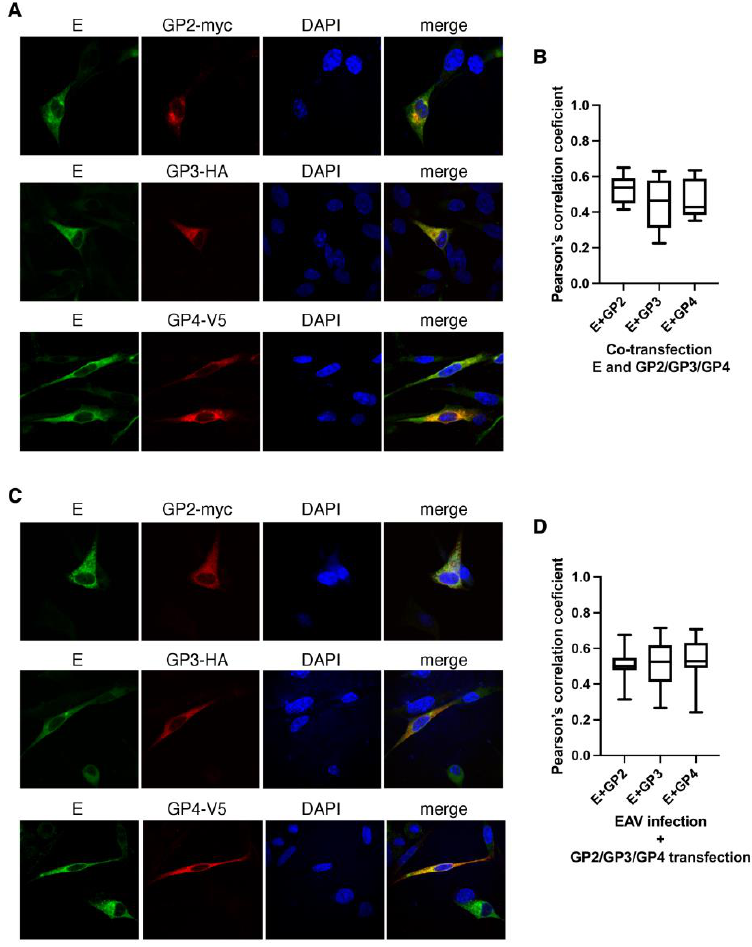
Figure 6. GP2-myc, GP3-HA, and GP4-V5 co-localize with E protein. BHK-21 cells were co-transfected with pGP2/GP3/GP4 and E in pMDK. ( A , B ) Then, 22 h after transfection, cells were fixed and subjected to immunofluorescence with rabbit anti-E (green) and mouse anti-myc (red), mouse anti-HA (red), and mouse anti-V5 (red). BHK-21 cells were first infected with the EAV Bucyrus strain at MOI 1. After 2 h, cells were washed and transfected with pGP2/GP3/GP4 ( C , D ). Then, 22 h after transfection, cells were fixed and subjected to immunofluorescence with rabbit anti-E (green) and mouse anti-myc (red), mouse anti-HA (red), and mouse anti-V5 (red). Experiments were performed in duplicates and at least 10 cells for each experiment were used to quantify the co-localization in 3D with Huygens Professional software. Pearson’s correlation coefficient graphs were generated with Prism software (GraphPad Software, San Diego, CA, USA). The graph shows the co-localization values for each glycoprotein with E protein in co-transfected cells ( B ), and in EAV-infected cells ( D ). DAPI: nucleus